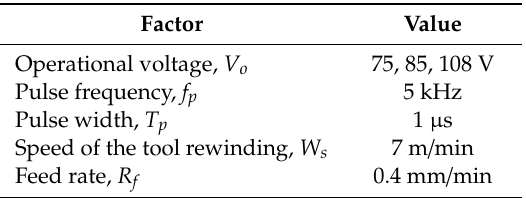
Table3. ElectricaldischargemachiningfactorsduringexperimentalworkformachiningAl 2 O 3 + 30%TiC in